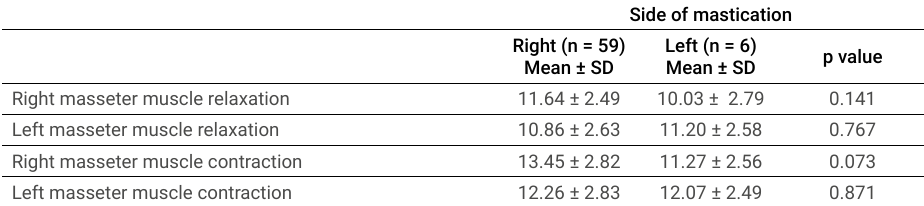
Table 3. Distribution of masseter muscle thickness according to the habitual side of